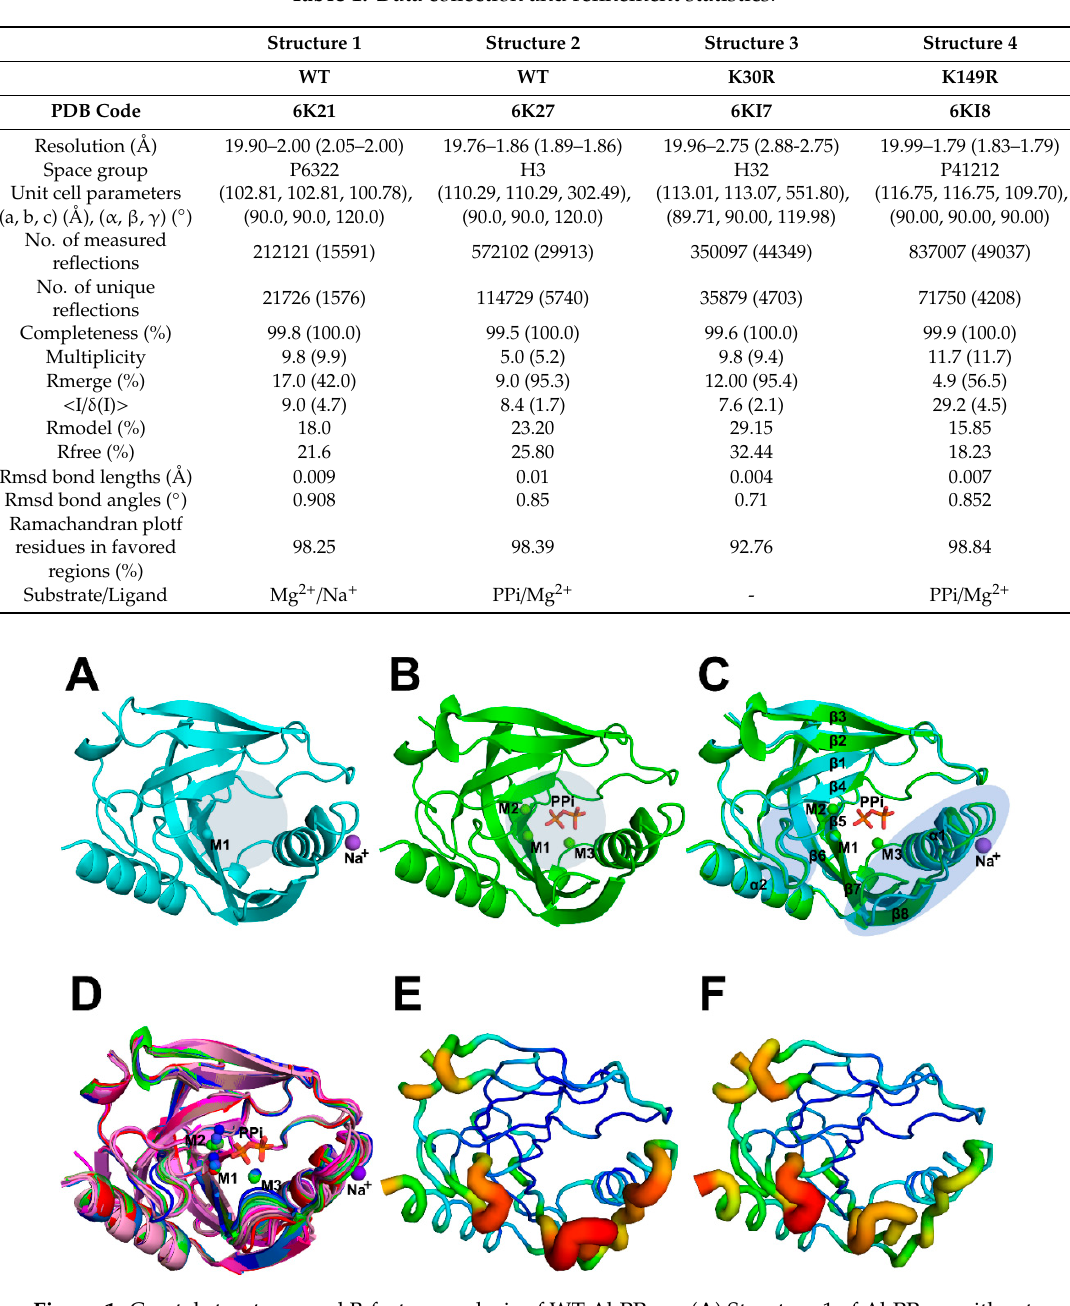
Table 1. Data collection and refinement statistics.